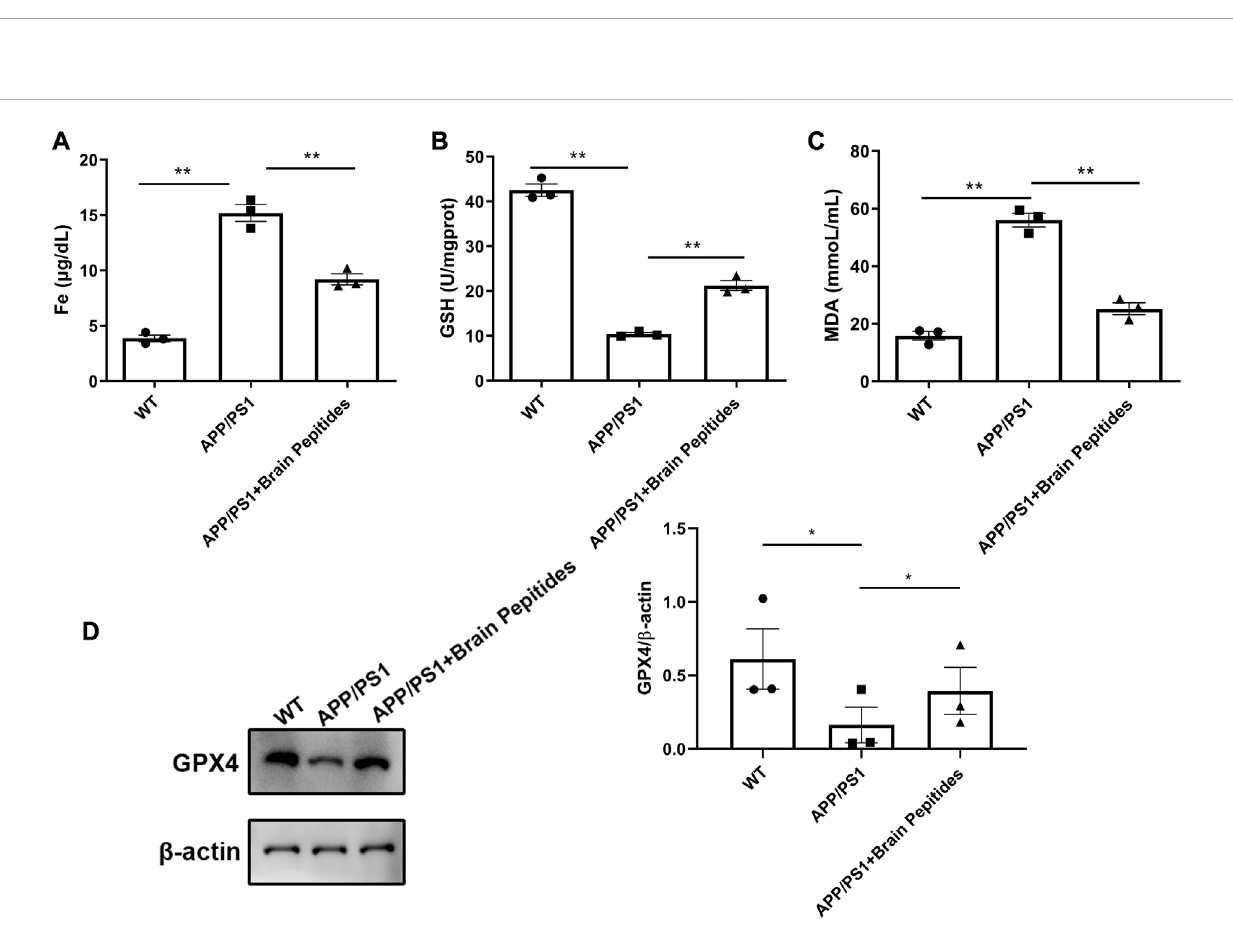
FIGURE 4 (A – C) Cerebroprotein hydrolysate regulates plasma iron, MDA, and GSH levels in APP/PS1 mice; (n = 3) (D) Cerebroprotein hydrolysate